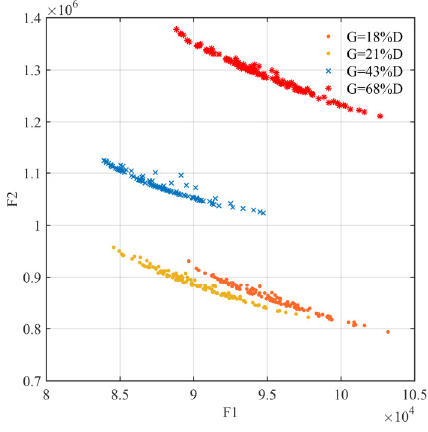
Figure 14. Price factors.